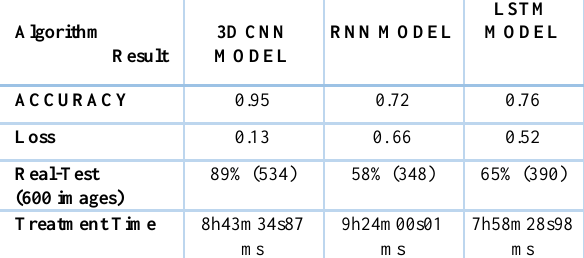
Figure 7. Classification algorithm comparison